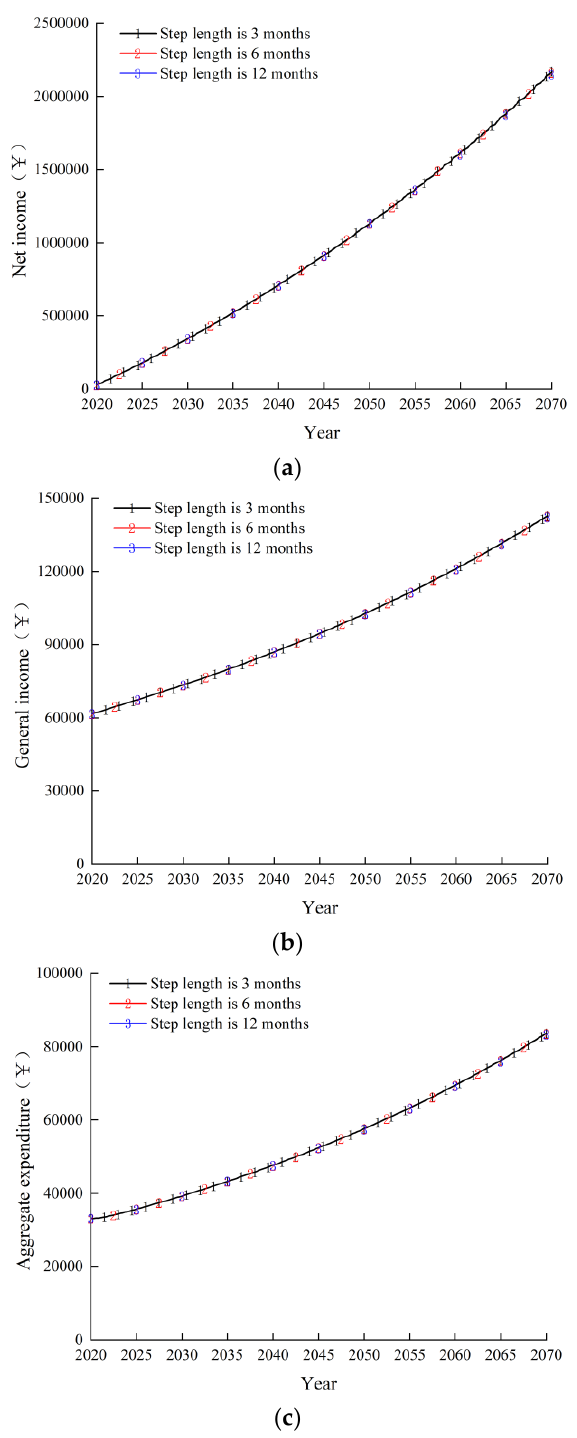
Figure 5. Results of the simulation under different time steps. ( a ) Net income; ( b ) General income; ( c ) Aggregate expenditure.